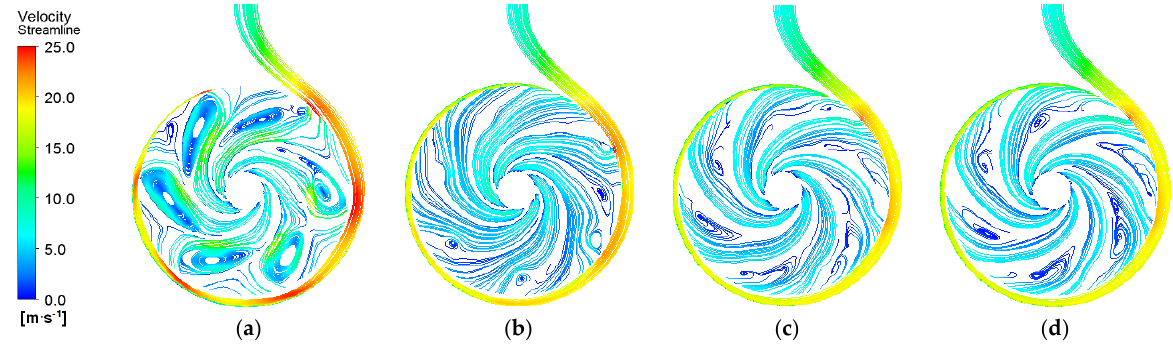
Figure 10. Velocity streamline distributions of axial vertical plane during start-up process. ( a ) t = 0.5 s; ( b ) t = 1.0 s; ( c ) t = 1.5 s; ( d ) t = 2.0 s.